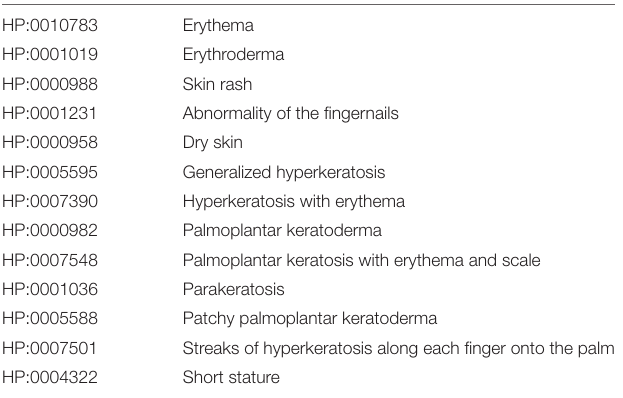
TABLE 1 | Detailed descriptions of clinical